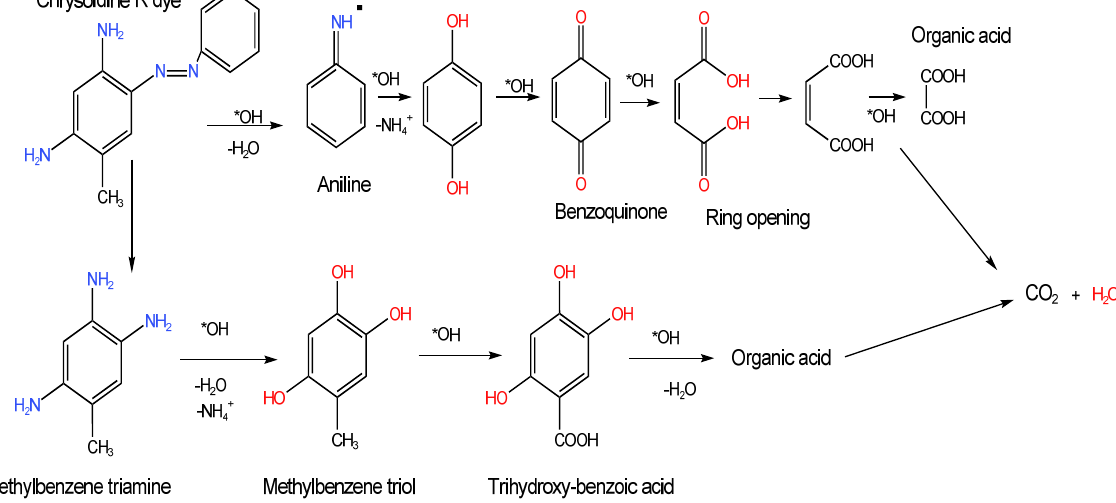
Figure 9. Proposed reaction mechanism of sono-catalytic degradation of Chrysoidine R dye (* or • denotes radical).